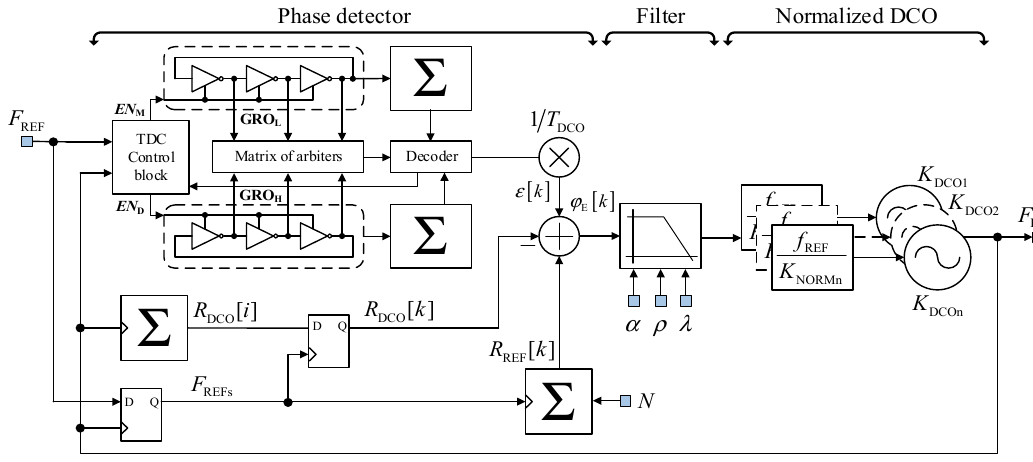
Figure 7. Phase domain model of all digital frequency synthesiser for multiband transceiver.